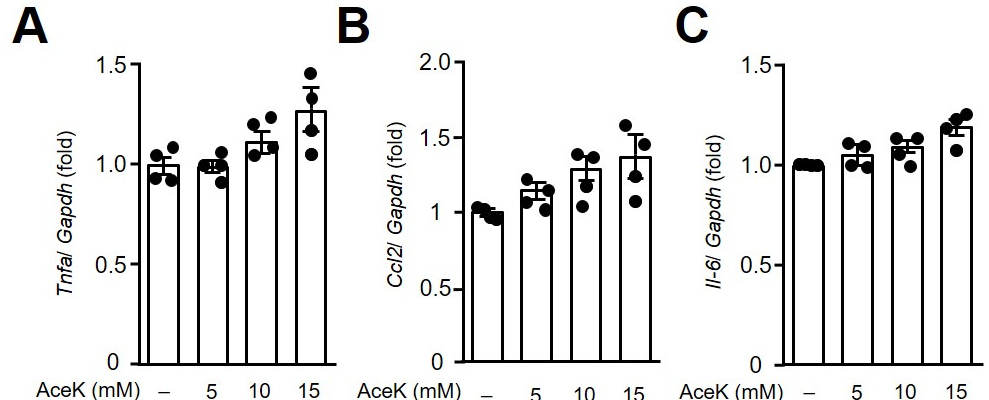
Figure 2. Effects of AceK on proinflammatory cytokine expressions in murine RAW264.7 macro- phages. Cells were treated with indicated doses of AceK for 24 h. The cells were harvested and RNA was isolated for the quantification of tumor necrosis factor alpha ( Tnfa ) ( A ), C–C motif chemokine ligand 2 ( Ccl2 ) ( B ), and interleukin-6 ( Il-6 ) ( C ) gene expressions by quantitative PCR ( n = 4).